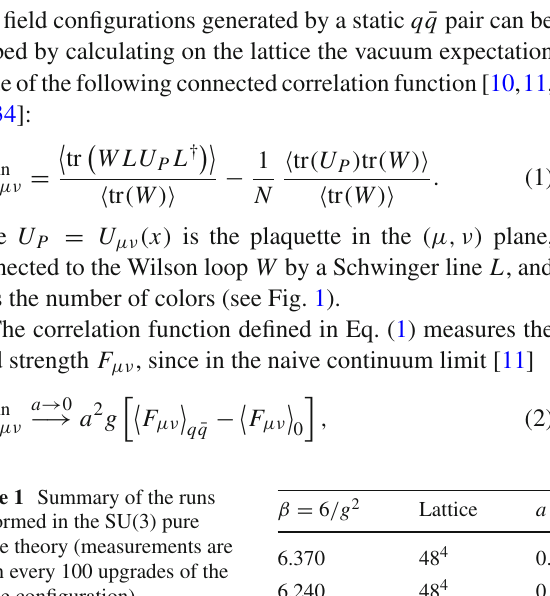
Table 1 Summary of the runs performed in the SU(3) pure gauge theory (measurements are taken every 100 upgrades of the lattice